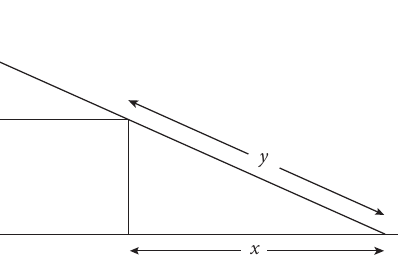
Figure 1: Beam positioning problem.